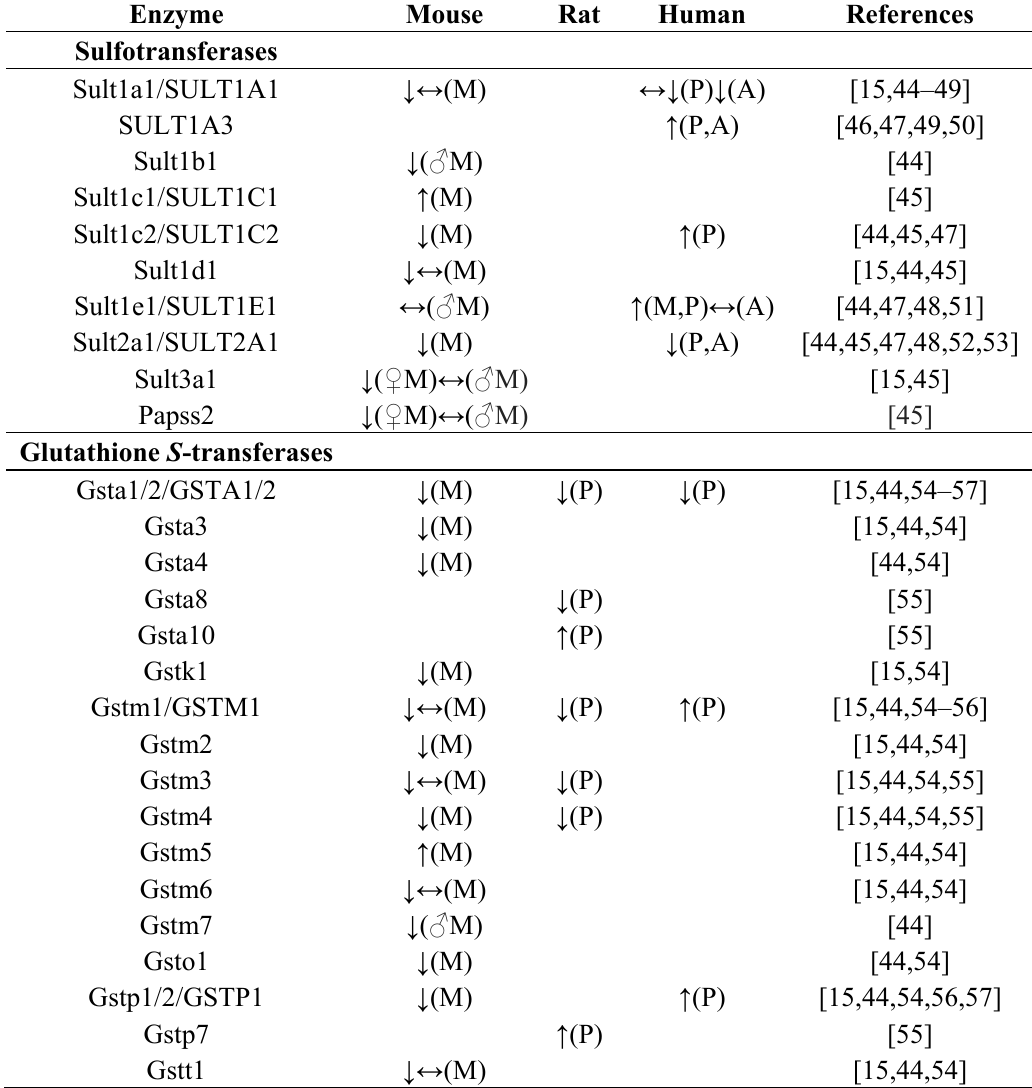
Table 3. Phase II metabolism in rodent and human fetal livers.